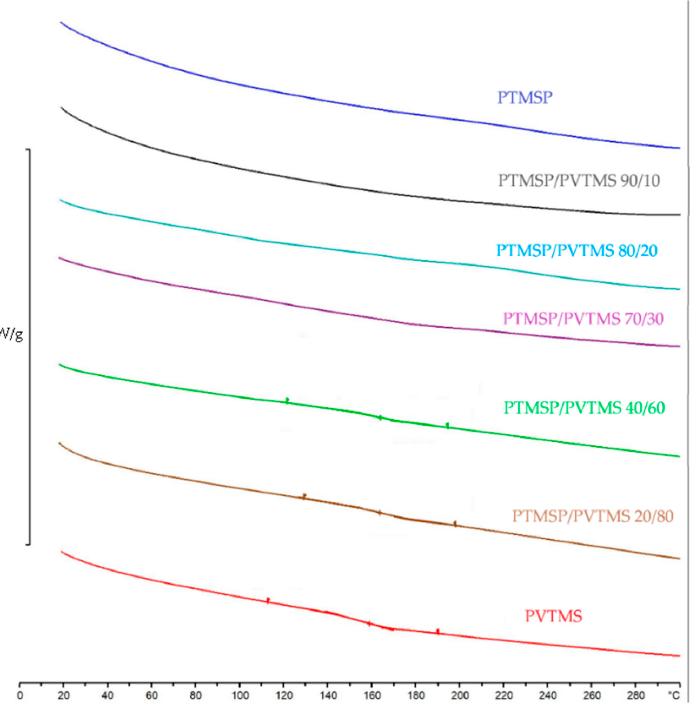
Figure 4. Thermograms of pure PTMSP, PVTMS samples, and PTMSP/PVTMS blends, investigated by the DSC method.